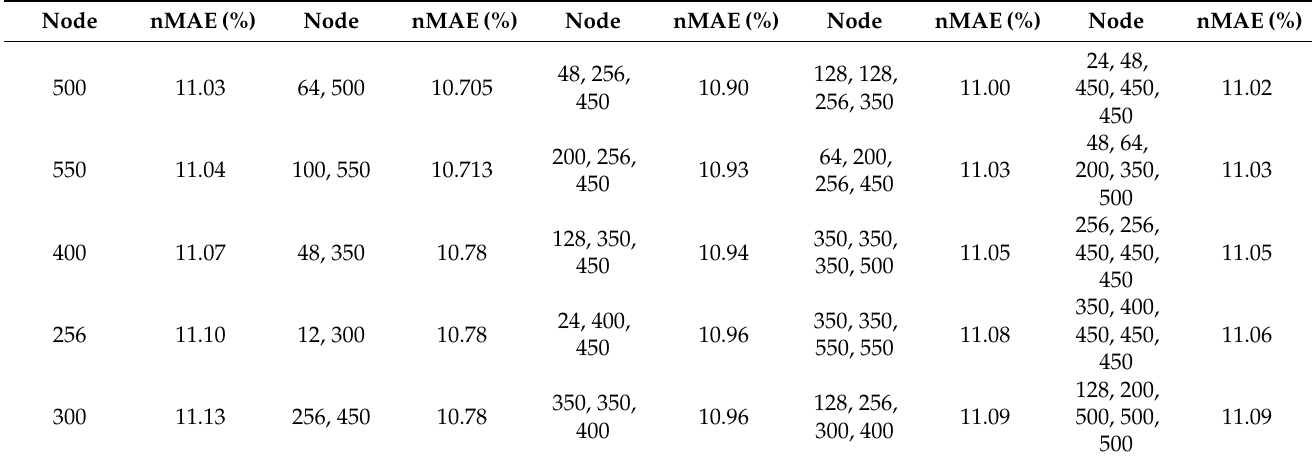
Table 5. Top 5 results of grid search by hidden layer configuration (5